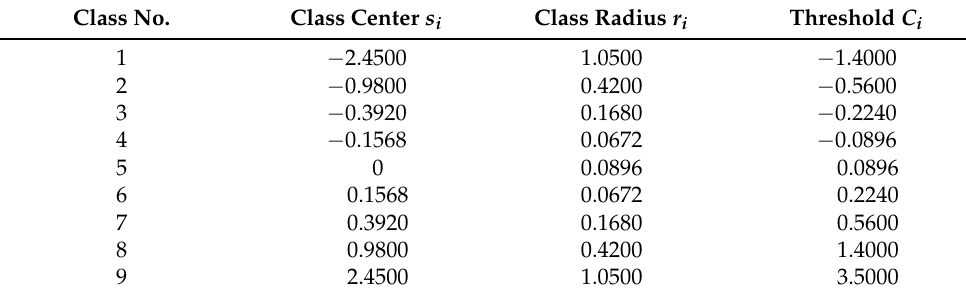
Table 2. Property values of pattern